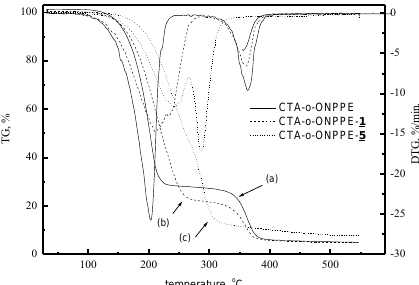
Figure 11. TG-DTA curves for membranes CTA-o-NPPE with carrier 1 (a) and 5 (b) [60]. Table 15. Degradation temperatures and weight losses of CTA- o -NPPE membranes with alkylimidazoles.